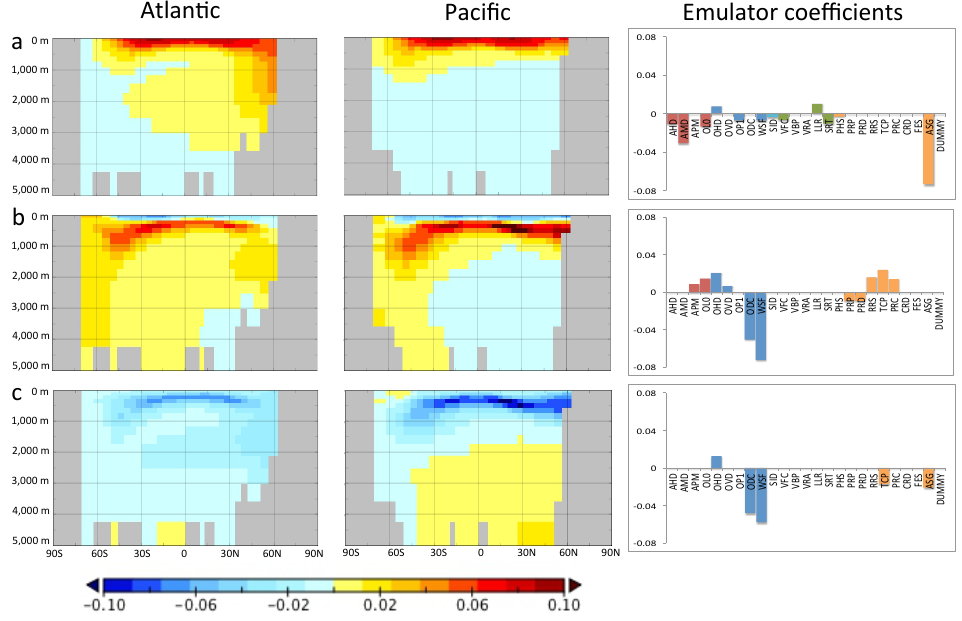
Fig. 12. EOFs and PC emulator coefficients for anthropogenically forced change (1858 to 2008AD). (a) First EOF of δ 13 C DIC change (63% of ensemble variance) (b) second EOF of δ 13 C DIC change (18% of ensemble variance) and (c) first EOF of DIC change (54% of ensemble variance). EOF magnitudes are in dimensionless